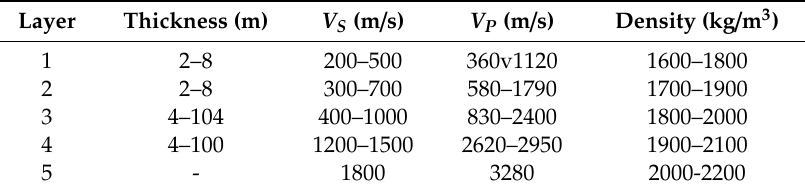
Table 2. Initial inversion parameter ranges for Site-2.